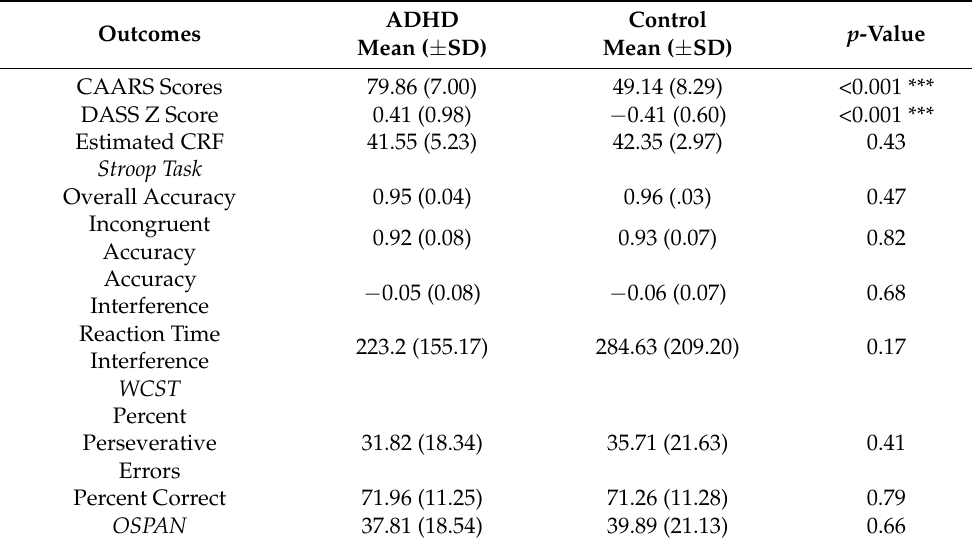
Table 2. Cognitive Outcomes and CRF